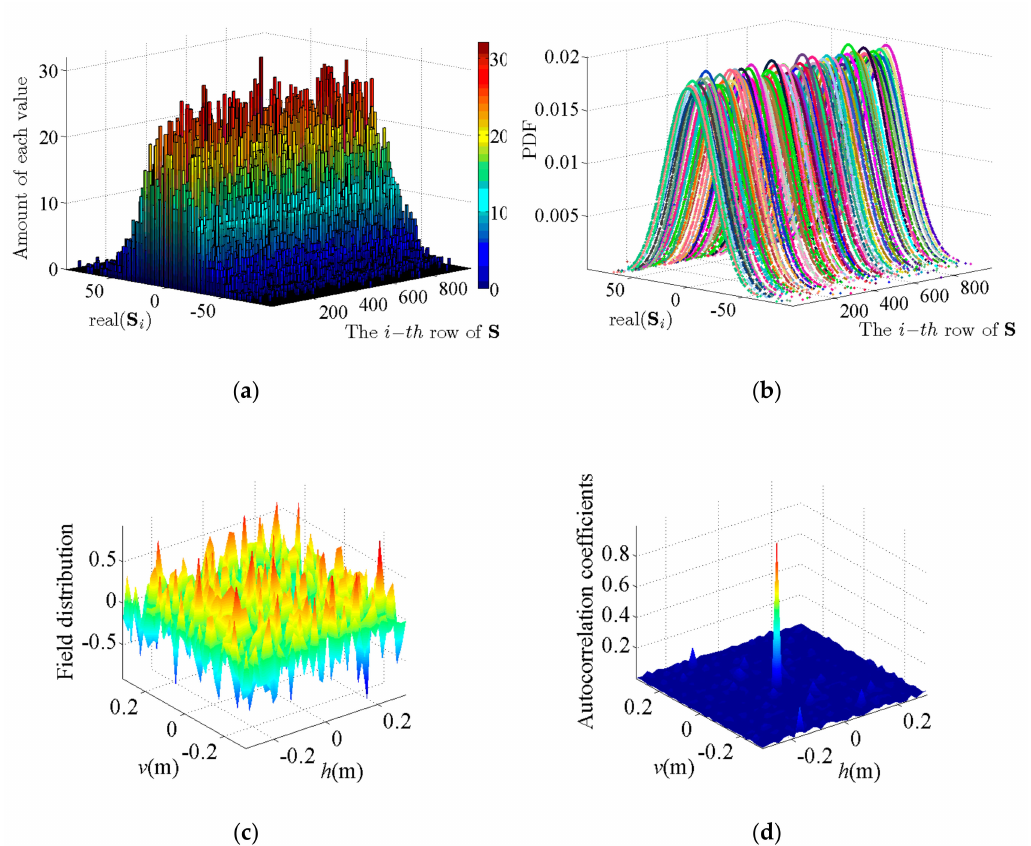
Figure 3. Characteristics of the reference signal that was derived from the PL-TCAI system: ( a ) frequency histogram of the real values of each { S i · } 1 ≤ i ≤ L ; ( b ) probability distribution function of the real values of each { S i · } 1 ≤ i ≤ L ; ( c ) instantaneous radiation field distribution of PL-TCAI; and ( d ) space independence function of